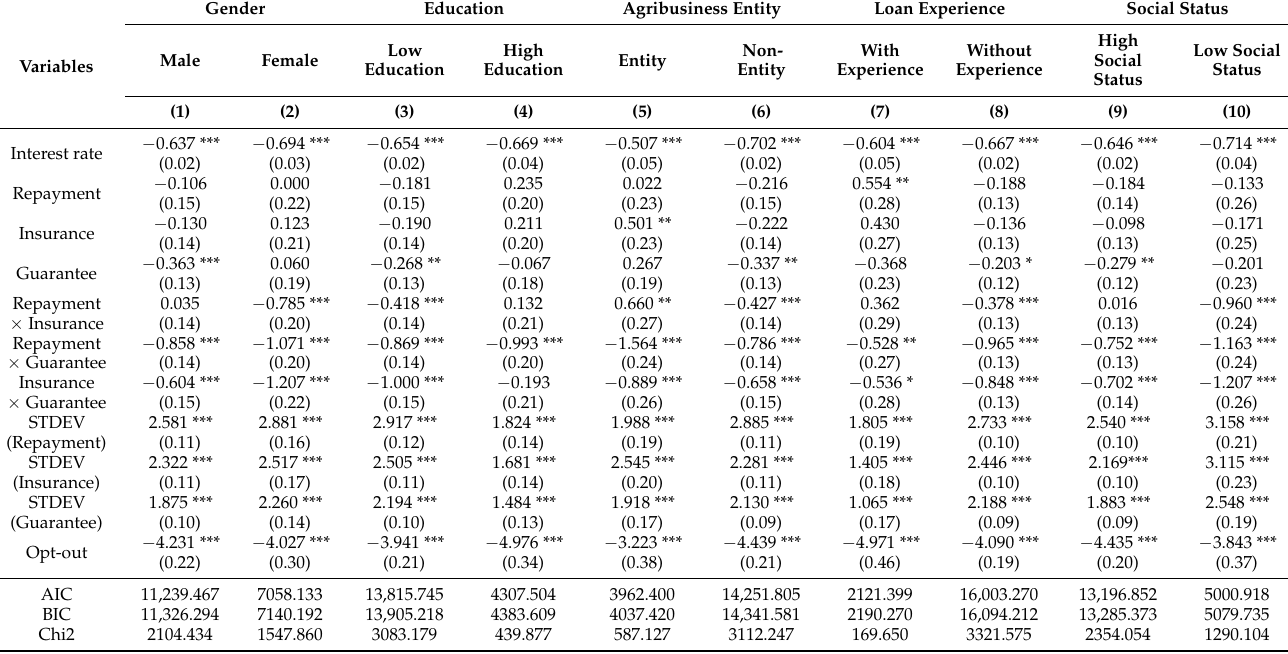
Table 4. Estimated RPL results across gender, education, agribusiness entity, loan experience, and social